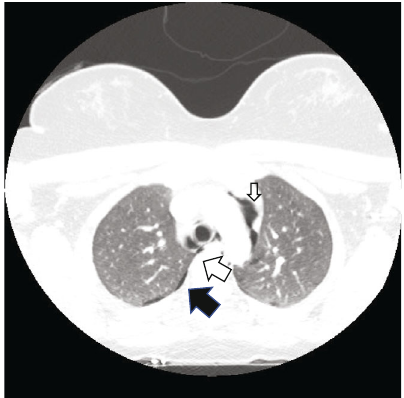
Figure 2: CT angiography of the head and neck. Small right apical pneumothorax (solid arrow) and pneumomediastinum (nonsolid arrows) are